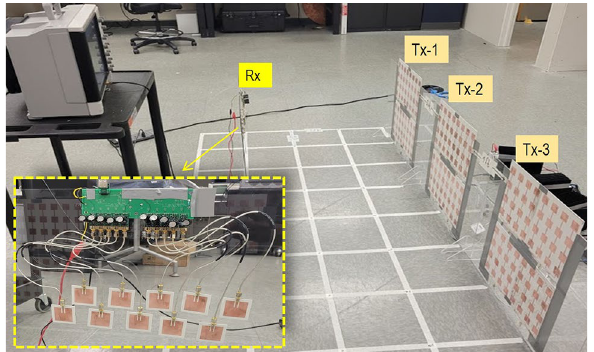
Figure 7. Experimental set-up to demonstrate the charging of the phone using the developed set-up.